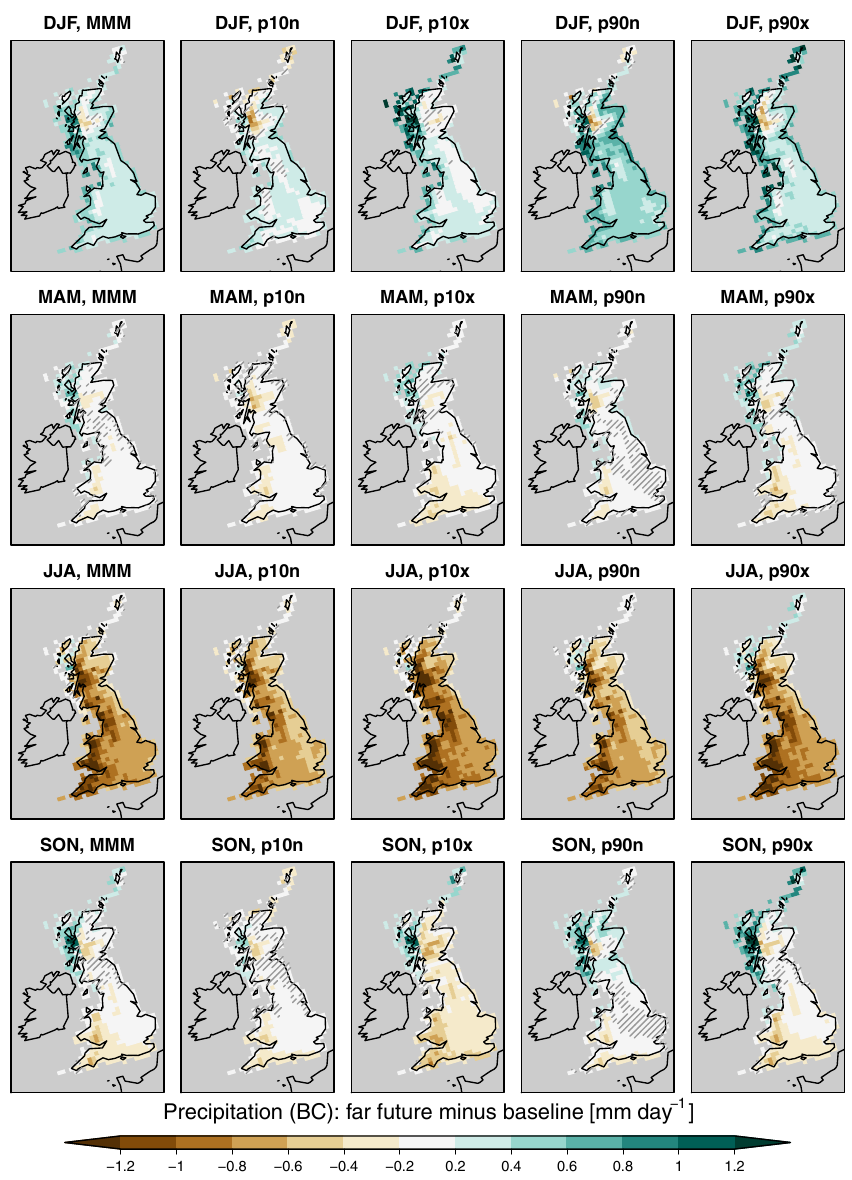
Figure 12. Same as Fig. 10 but for precipitation (bias corrected, prbc). Hatching indicates grid cells with statistically non-significant changes at the 95% level according to a two-sided T test. The corresponding figure for the near-future time slices is shown in Fig.